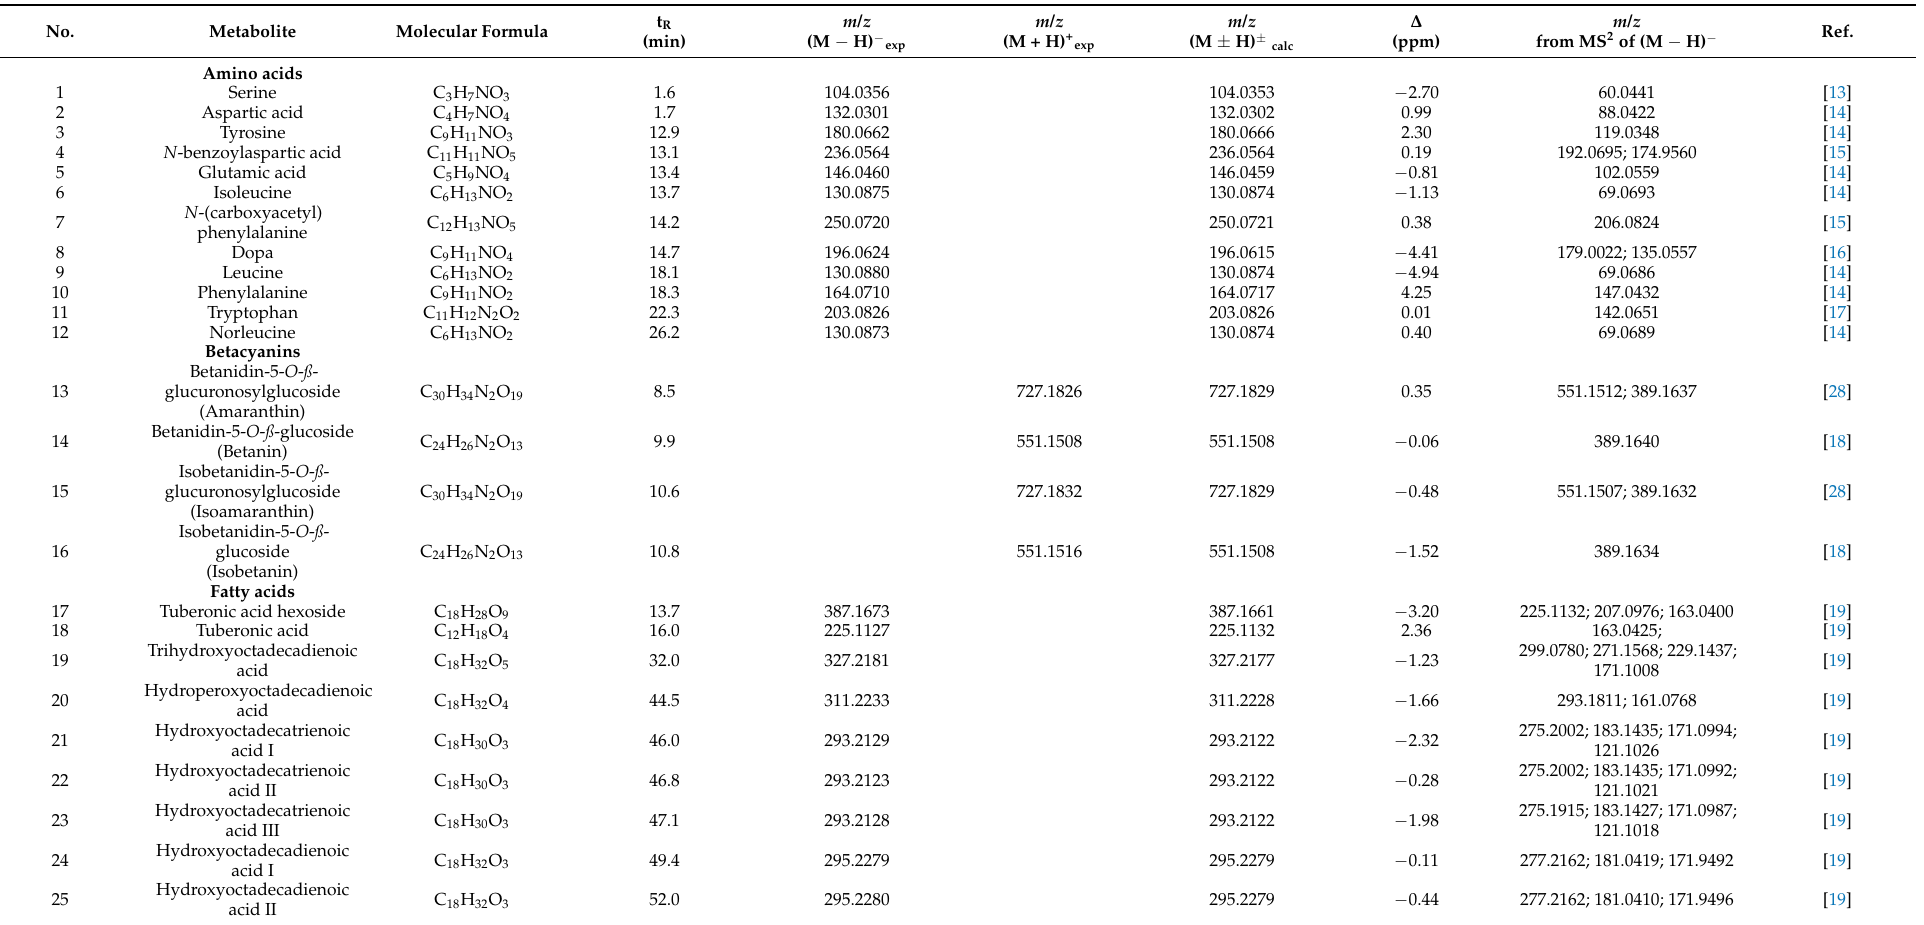
Table 1. High-resolution mass spectrometric data obtained by HPLC-DAD-ESI-HRMS/MS for metabolites of three cultivars of A. tricolor Calaloo (Red, Passion and Green) analyzed in negative and positive ionization